Question: Provide a one-line summary of what is displayed.
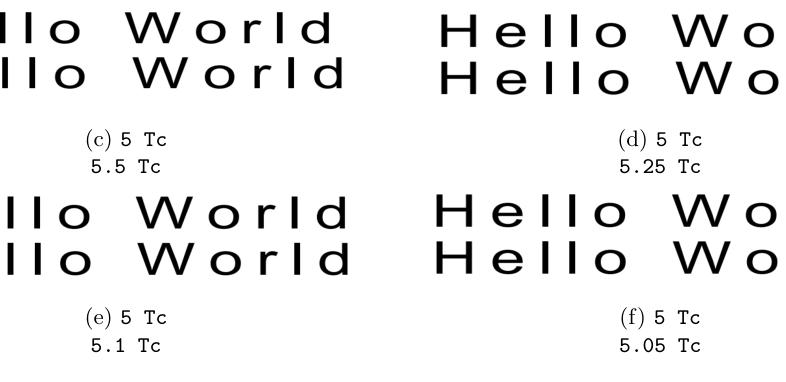
Answer: Tc Operator - control, 20%, 10%, 5%, 2%, 1% (1%, less stable)